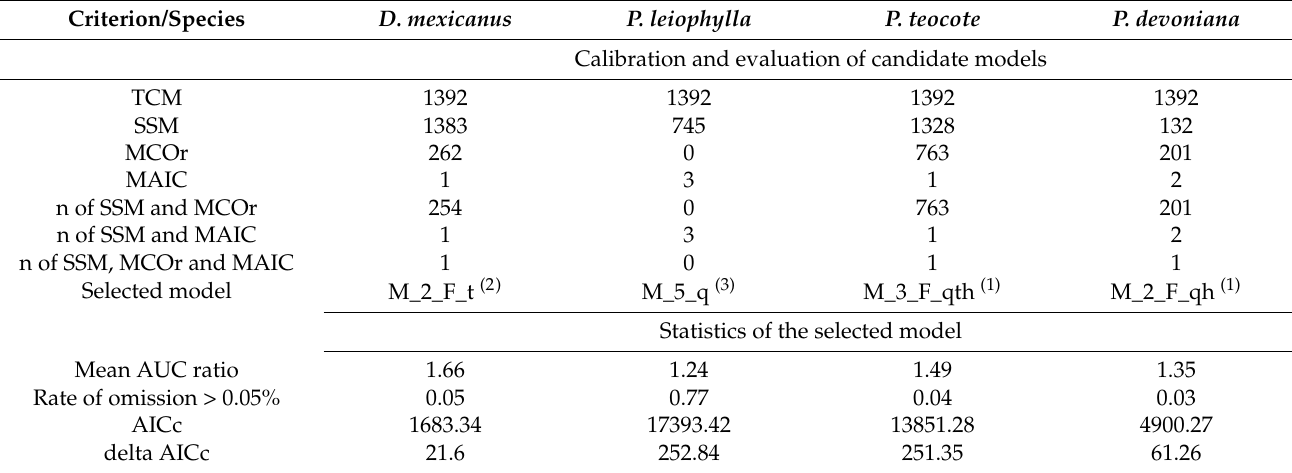
Table 2. Candidate models generated and selected, and their fit and validation statistics.